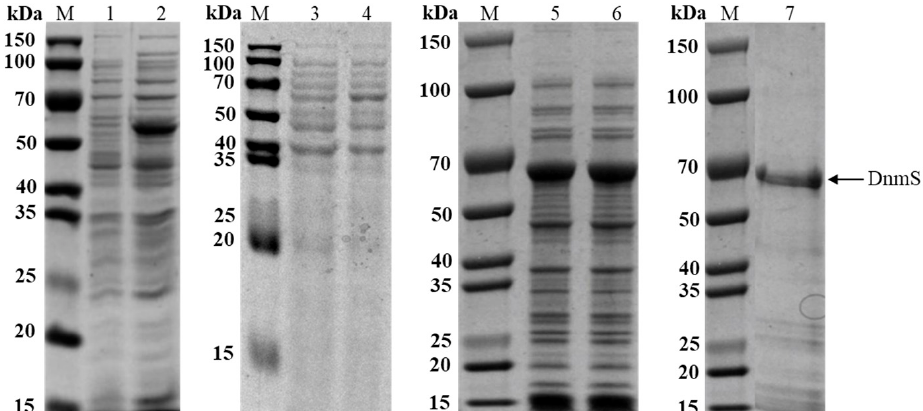
Figure 3. Expression of DnmS with different fusion partners in E. coli . Lane 1, 32aS/DE3 induced supernatant; Lane 2, 32aS/DE3 induced total protein; Lane 3, 32aS/pGro7 induced supernatant; Lane 4, 32aS/pGro7 induced total protein; Lane 5, 32aS/pGro7 ′ induced supernatant; Lane 6, 32aS/pGro7 ′ induced total protein; and Lane 7, DnmS purified from 32aS/pGro7 ′ ; M, protein marker (Genestar, 15, 20, 25, 35, 40, 50, 70, 100 and 150 kDa.).